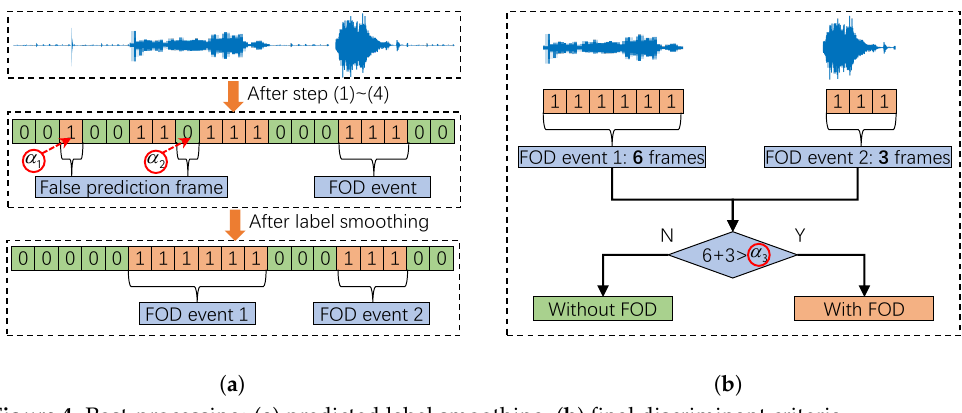
Figure 4. Post-processing: ( a ) predicted label smoothing, ( b ) final discriminant criteria. The specific algorithm pseudo-code for post-processing is shown in Algorithm 1. Algorithm 1: